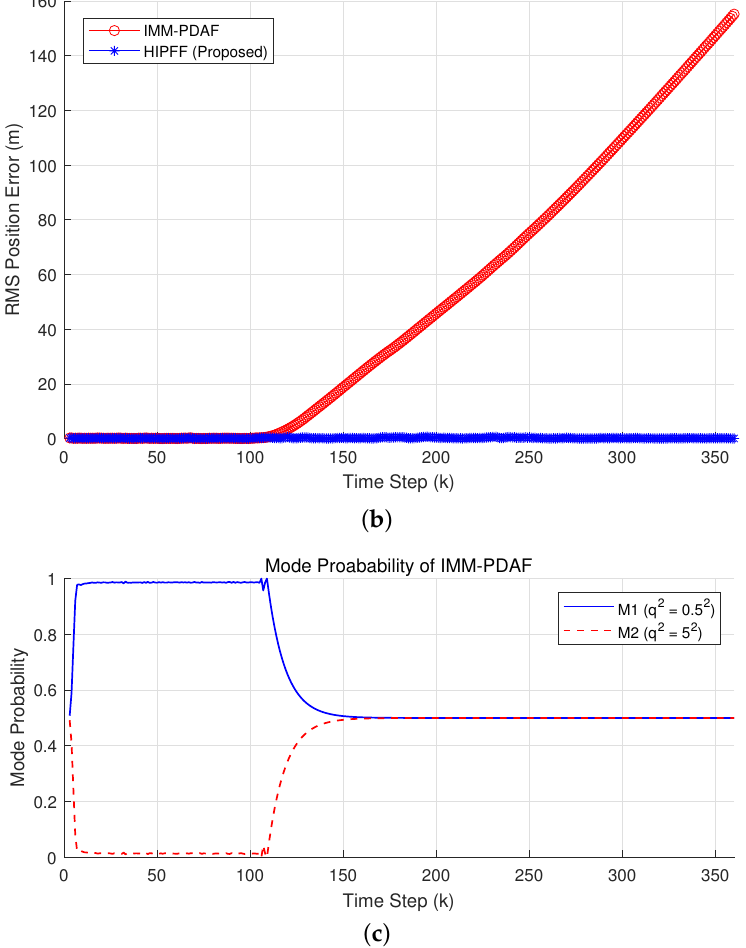
Figure 7. Results of 3D localization using IMM-PDAF and HIPFF when the IMM-PDAF diverges: ( a ) trajectory of mobile node, ( b ) RMS position error and ( c ) mode probabilities.